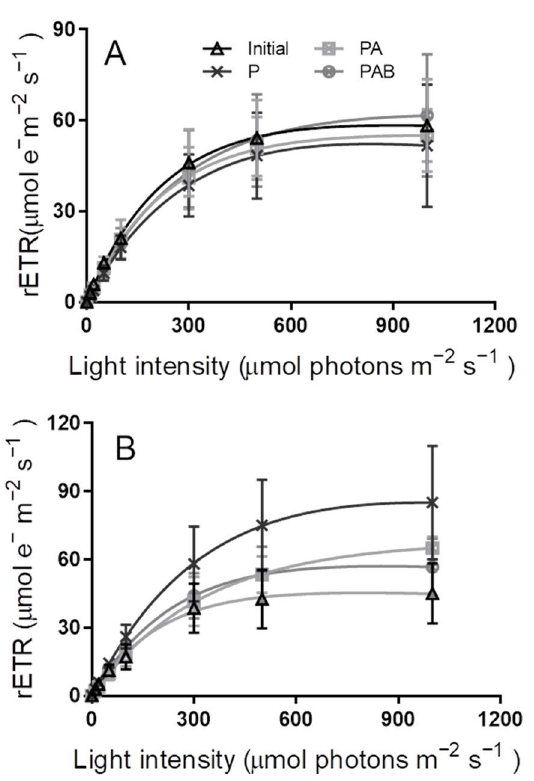
Figure 3. The electron transport rates of Sargassum horneri with LN ( A ) and HN ( B ) under P, PA, and PAB treatments. Significant differences among all treatments are indicated by different low- ercase letters ( p < 0.05).